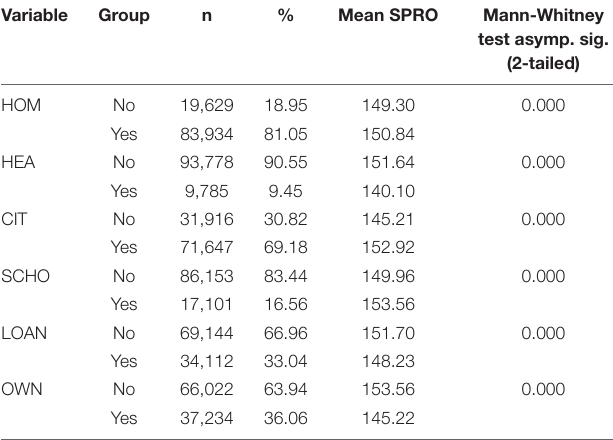
TABLE 1 | Profile of students’ variables: HOM, HEA, CIT, SCHO, LOAN, and OWN. Variable Group